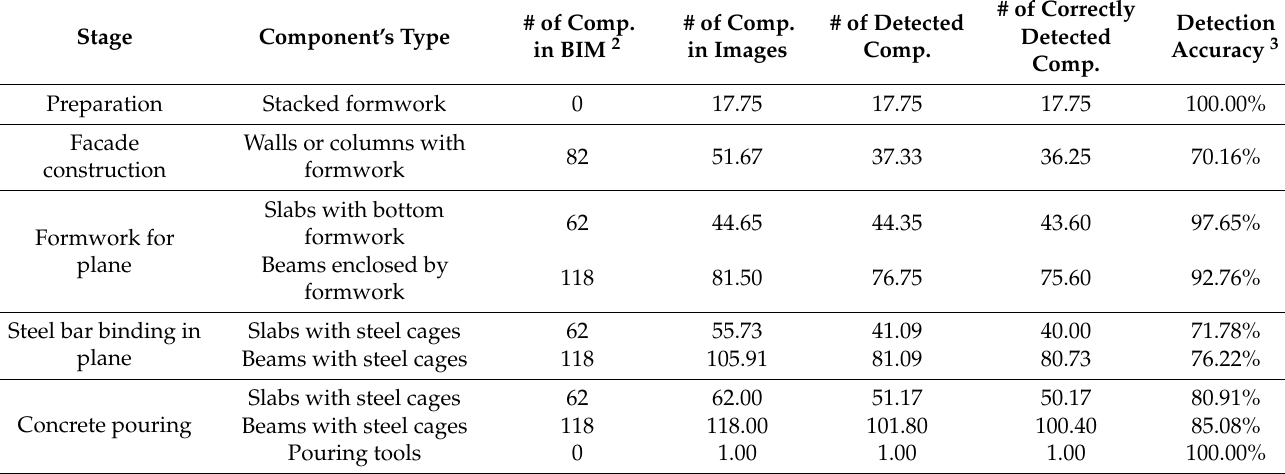
Table 3. Detection results 1